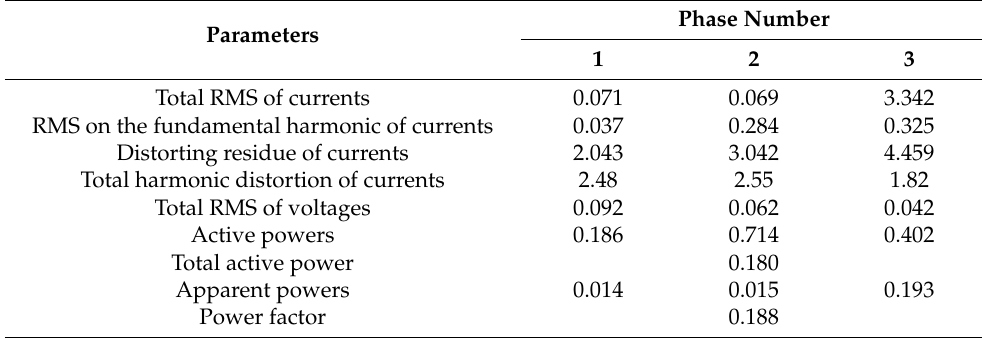
Table 6. Computed percentage relative differences between power quality index (FFT vs.